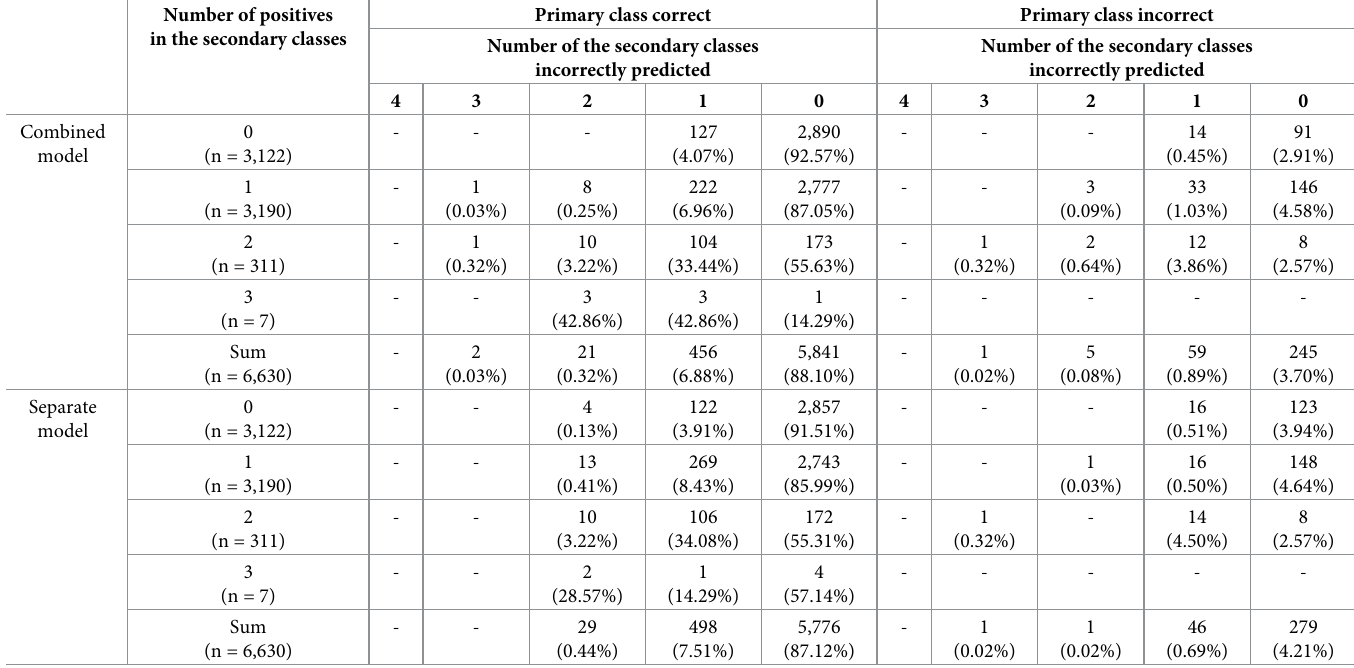
Table 2. Comparison of prediction accuracy between combined and separate models according to the number of positives in the secondary classes.